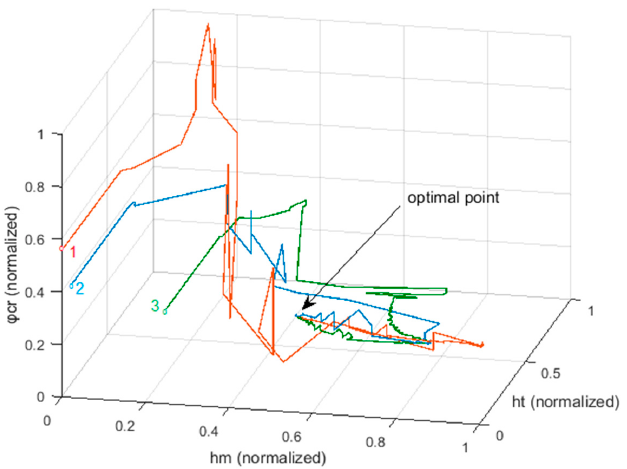
Figure 4. Optimization paths of the mass and heat transfer coefficients and the critical relative humidity ( h m , h T , and φ cr ) (drying scheme CVUD_502200).